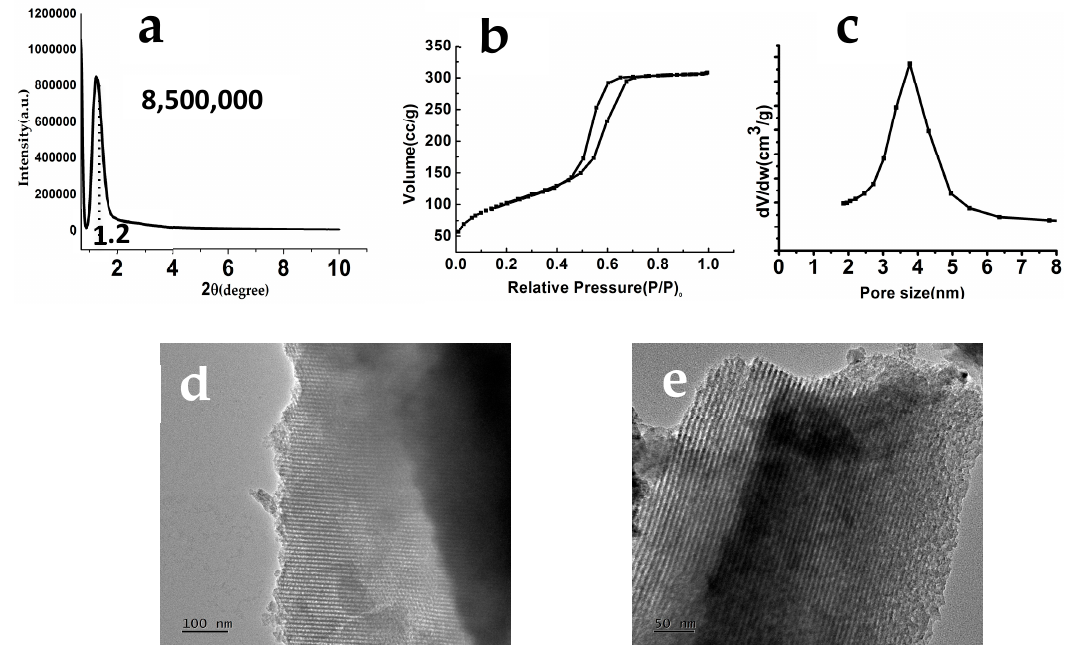
Figure 3. Grazing incidence X-ray diffraction (GIXRD) pattern of the MBG-coated Ti-6Al-4V scaffolds ( a ); nitrogen adsorption − desorption isotherms of the MBG powder ( b ); pore size distribution extracted from the N2 adsorption isotherms of the MBG powder ( c ); and TEM images for the MBG-coated Ti-6Al-4V scaffolds ( d , e ) with a well-ordered mesopore channel structure.